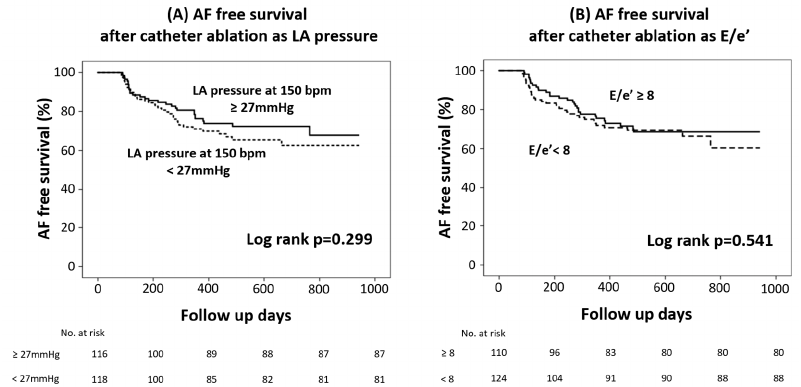
Figure 4. Atrial fibrillation/atrial tachycardia free survival as a clinical outcome after catheter ablation. ( A ) High ( ≥ 27 mmHg at 150 bpm) versus low (<27 mmHg at 150 bpm) left atrial pressure response group. ( B ) High (E/e’ ≥ 8) versus low (E/e’ < 8) E/e’ group. AF, atrial fibrillation; AT, atrial tachycardia; LA, left atrial.